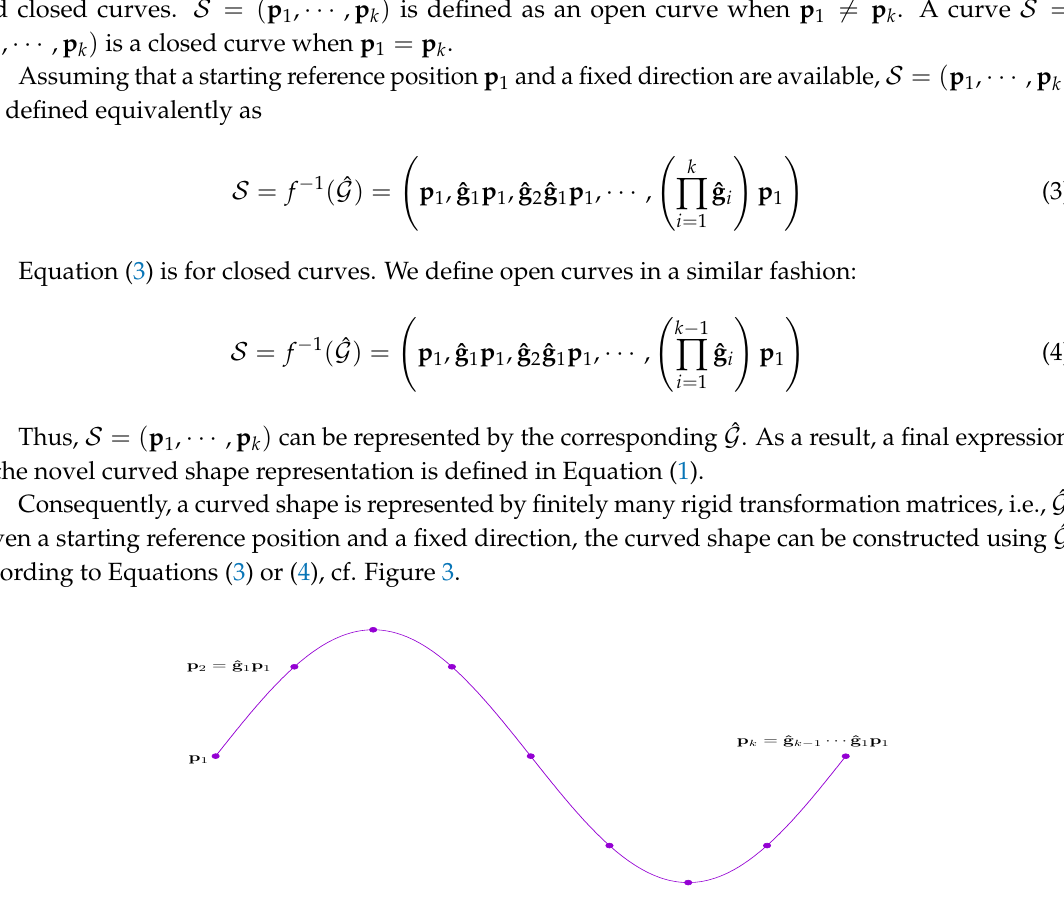
Figure 3. Given a fixed starting position p 1 , the curve is reconstructed by the successive application of the transformations ( ˆg 1 ,